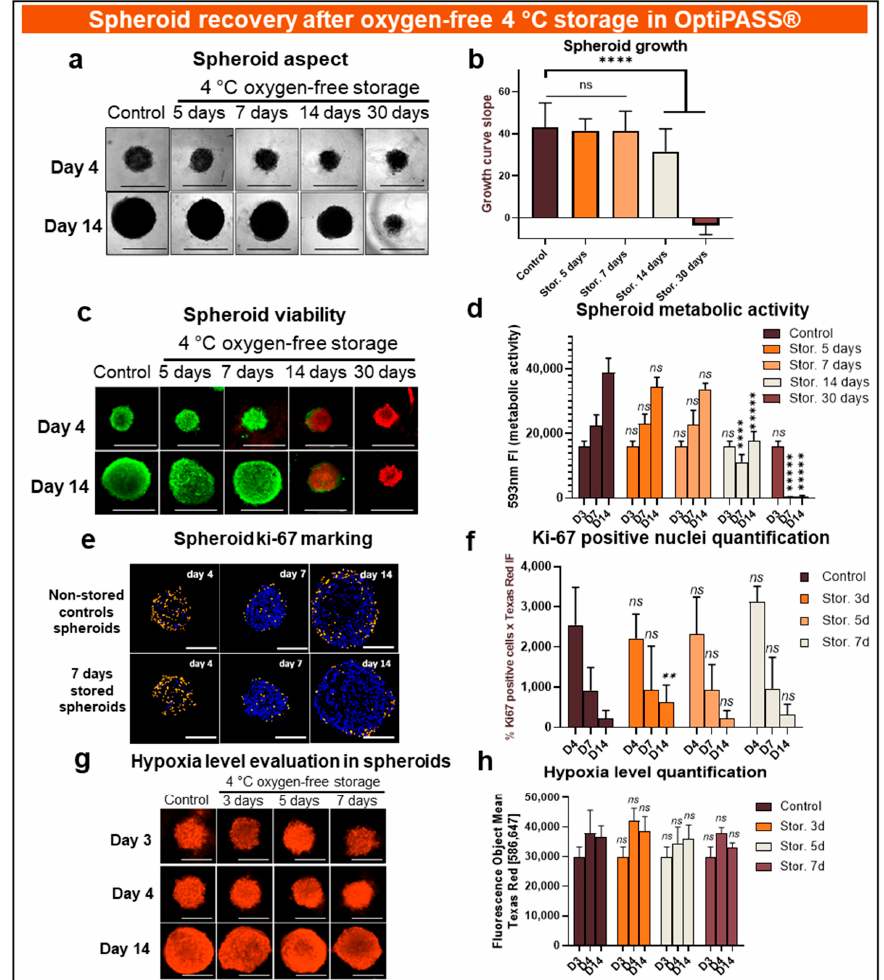
Figure 4. MDA-MB-231 spheroid preservation analysis after several days of storage in oxygen-free and 4 °C storage in OptiPASS ® medium culture. Three-day-old spheroids cultured in normal culture conditions, i.e., 37 °C, 5% CO 2 in OptiPASS ® medium culture were exposed to oxygen-free conditions at 4 °C for 5, 7, 14 or 30 days. After each storage time, spheroid recovery was analyzed in comparison to nonstored control spheroids. Samples’ integrity aspects and sizes ( a ) were studied with bright field microscopy and object size algorithm (Cytation™3MV, Gen5, BioTek ® , M = 4X, scale bar = 1000 µ m). Growth curve slopes were calculated using spheroids’ size values between the 4th and the 14th days of culture, reflecting recovery of proliferation capacities after storage step ( b ). Spheroid viability after storage was assessed by Live/Dead ® tests showing viable cells (green fluorescence) and dead cells (red fluorescence) using Cytation™3MV equipped with GFP and IP fluorescence cubes (M = 4X, scale bar = 1000 µ m) ( c ). Complementary to this, spheroid metabolic activity was quantified using resazurin tests ( d ). Otherwise, spheroid tumoral proliferation gradient analysis was carried out by ki67 immunostaining at D4, D7 and D14 and imaged with Texas Red filter (M = 10X, scale bar = 200 µ m) on Cytation™3MV instrument (BioTek ® ). Ki67-positive nuclei (in orange) were identified among other nuclei (in blue) with adapted algorithm on Gen5 software (BioTek ® , pictures showed for nonstored controls and spheroids stored for 7 days) ( e ). Global ki67-expression was quantified and compared between nonstored controls and 3-, 5- and 7-day-long cold and oxygen-free storage conditions in OptiPASS ® medium ( f ). Finally, spheroid hypoxia level was studied using ROS-ID ® kit staining at D3, D4 and D14 ( g , h ). Spheroids were imaged with Cytation™3MV equipped with Texas Red fluorescence cube (M = 4X, scale bar = 500 µ m) ( g ). Hypoxia level was quantified by acquired fluorescent signal intensity with Gen5 software (BioTek ® ) (h). For each storage condition, significances compared to nonstored condition were indicated as ns (not significant; p > 0.05), ** p < 0.01, **** p < 0.0001, ***** p <